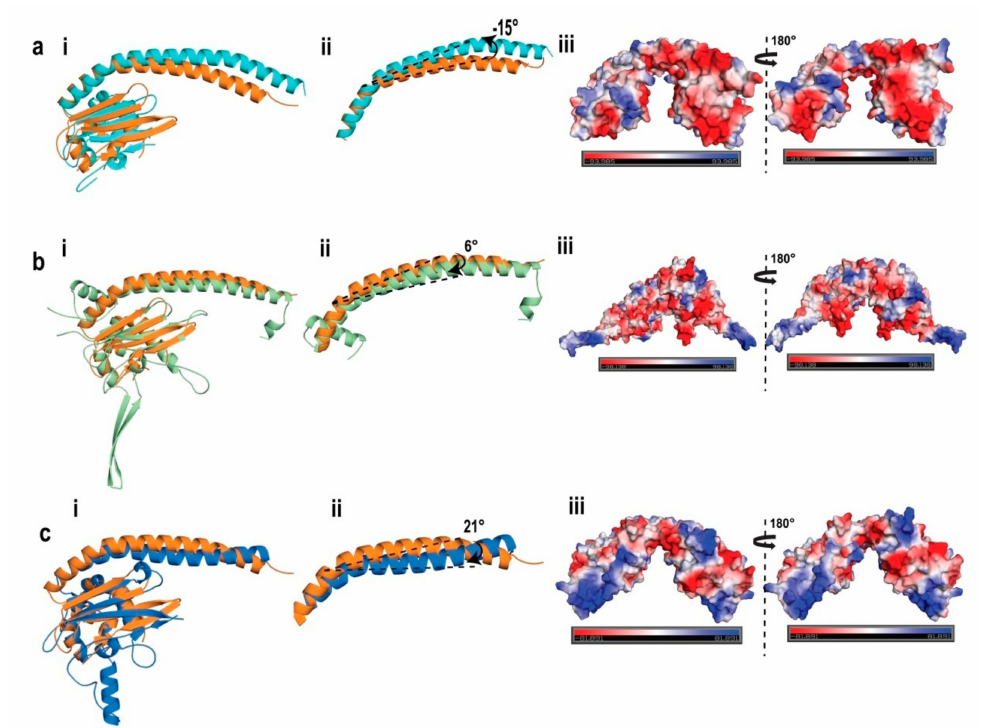
Figure 6. Comparison of AtNRP2 structure with the structure of other NAP family proteins. ( a ) (i) Structure superposition of AtNRP2 (orange) with HsSET / TAF-1 β (PDB id: 2E50; cyan) r.m.s.d. = 4.94 Å for 304 C α atoms. (ii) Figure highlighting the o ff set in the dimerization helix of AtNRP2 with HsSET / TAF-1 β . (iii) Surface electrostatic potential of HsSET / TAF-1 β in two orientations. ( b ) (i) Structure superposition of AtNRP2 (orange) with ScNAP1 (PDB id: 2Z2R; green) r.m.s.d. = 2.49 Å for 268 C α atoms. (ii) Figure highlighting the o ff set in the dimerization helix of AtNRP2 with ScNAP1 (iii) Surface electrostatic potential of ScNAP1 in two orientations. ( c ) (i) Structure superposition of AtNRP2 (orange) with ScVPS75 (PDB id: 3DM7; blue) r.m.s.d. = 3.36 Å for 208 C α atoms. (ii) Figure highlighting the o ff set in the dimerization helix of AtNRP2 with ScVPS75. (iii) Surface electrostatic potential of ScVPS75 in two